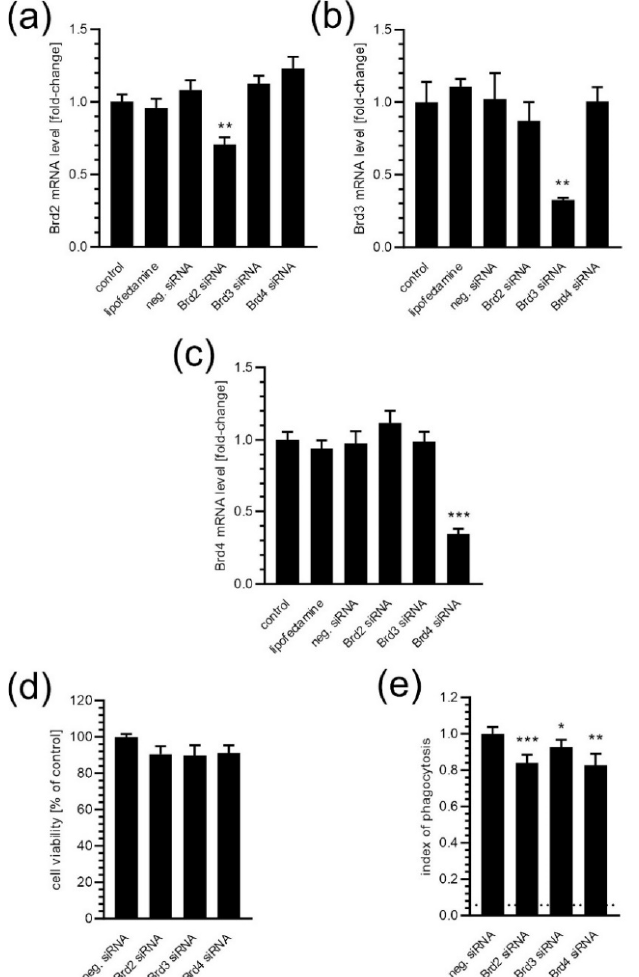
Figure 4. The effect of BET silencing on fluorescent microspheres’ (FMSs) phagocytosis by microglia. ( a – c ) mRNA levels for Brd2 , Brd3 , Brd4 genes 24 h after gene silencing. ( d ) The effect of Brd2 , Brd3 , and Brd4 gene silencing on viability BV2 cells (MTT assay). ( e ) The BV2 cells were subjected to gene silencing. After 24 h, FMS were added for 2 h. Cells were stained with blue nuclear dye and flow cytometric analysis was performed. The level of non-specific labelling is shown with a dotted line. Means ± SEM are presented. n = 8 ( a – c ), n = 4 ( d ), n = 12 ( e ); * p < 0.05, ** p < 0.01, *** p < 0.001, compared to the negative siRNA-treated group. Statistical analysis was performed by using a one-way ANOVA followed by the Bonferroni post hoc test.